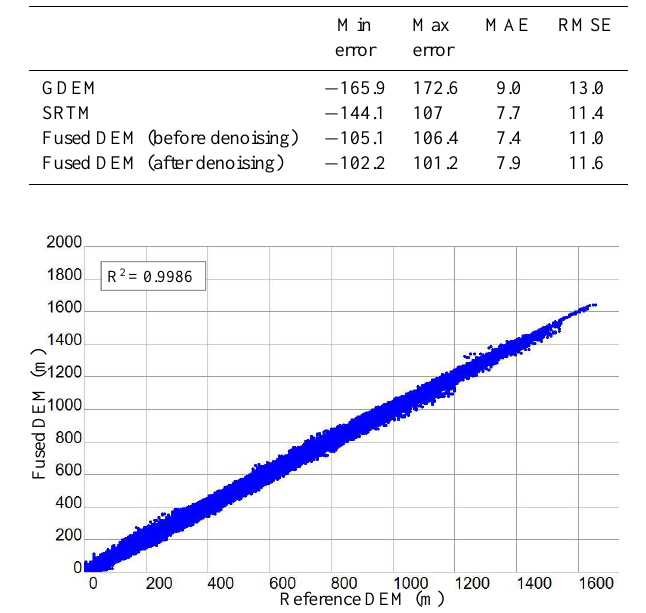
Figure 13. Correlation between the fused DEM and reference DEM.